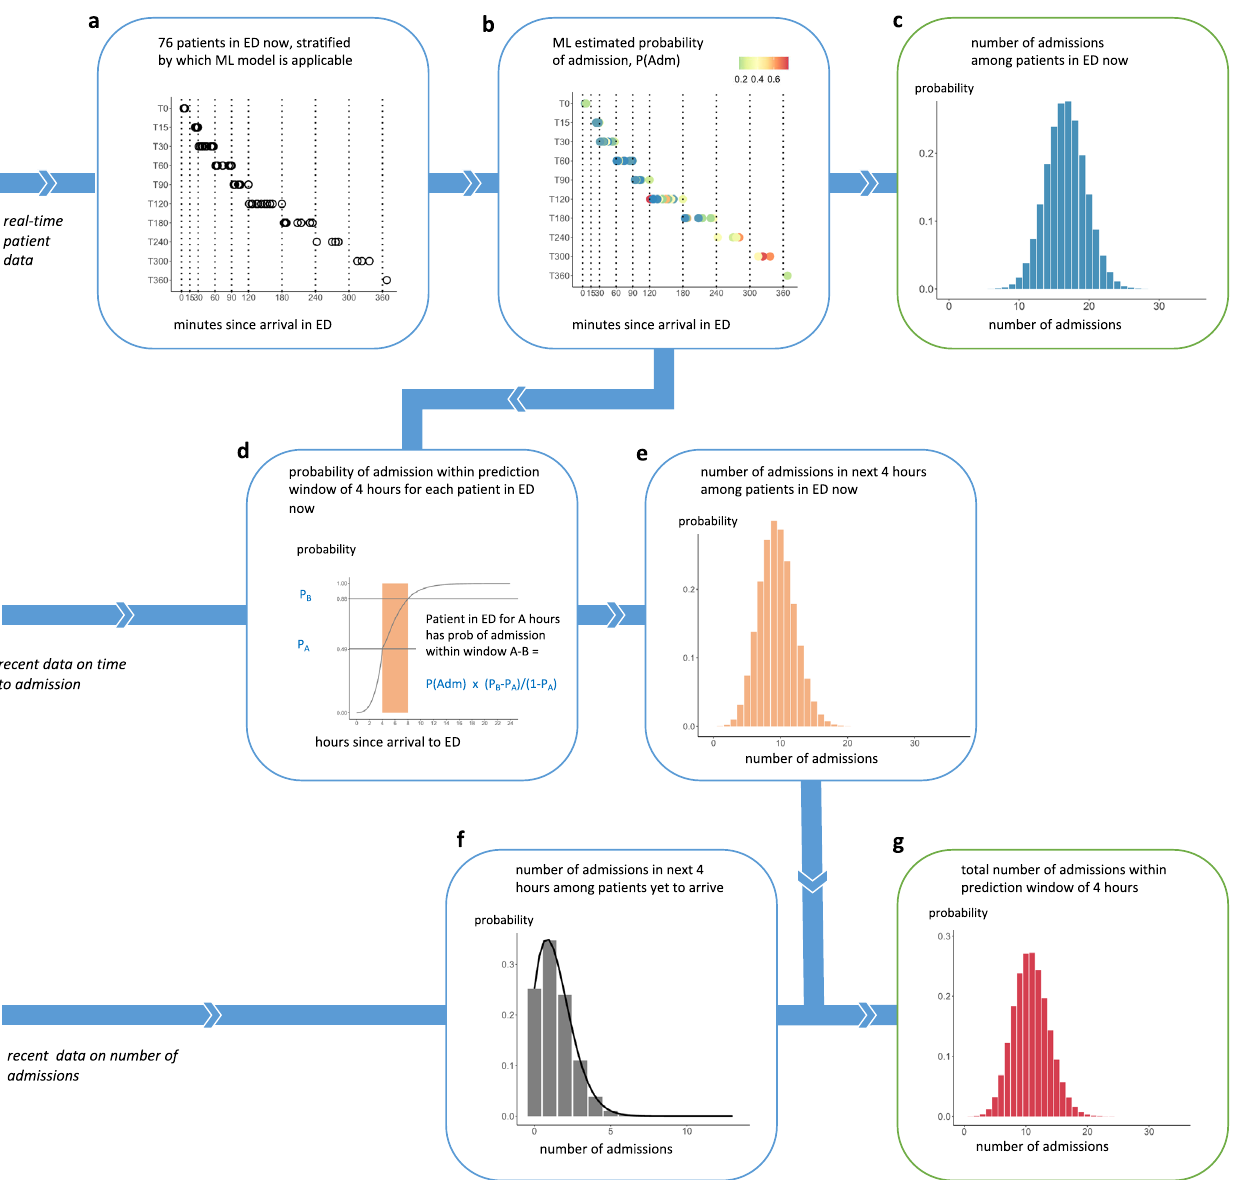
Fig. 1 Example of the seven-step prediction pipeline using a real example, predicting the number of admissions within 4 hours after 16:00 on 11 May 2021. a Illustrates the roomful of patients in the ED at the prediction time on the day of interest, grouped according to how long they had been in the ED since arrival. b Shows each patient ’ s probability of admission, generated using a set of ML models. These are combined in c into a probability distribution for the number of admissions among this roomful of patients. d Shows how, for each patient, the probability of admission within 4 hours would be calculated from recent data on time to admission, taking into account the time the patient has been in the ED up to the prediction time. e Shows a probability distribution for the number of admissions among the roomful of patients within the prediction window of 4 hours. f Shows a probability distribution over the number of patients who have not yet arrived, who will be admitted in the prediction window, generated by a Poisson equation from recent data on number of admissions. g Shows the fi nal probability distribution for the number of admissions, including patients in the ED now and those yet to arrive, within the prediction